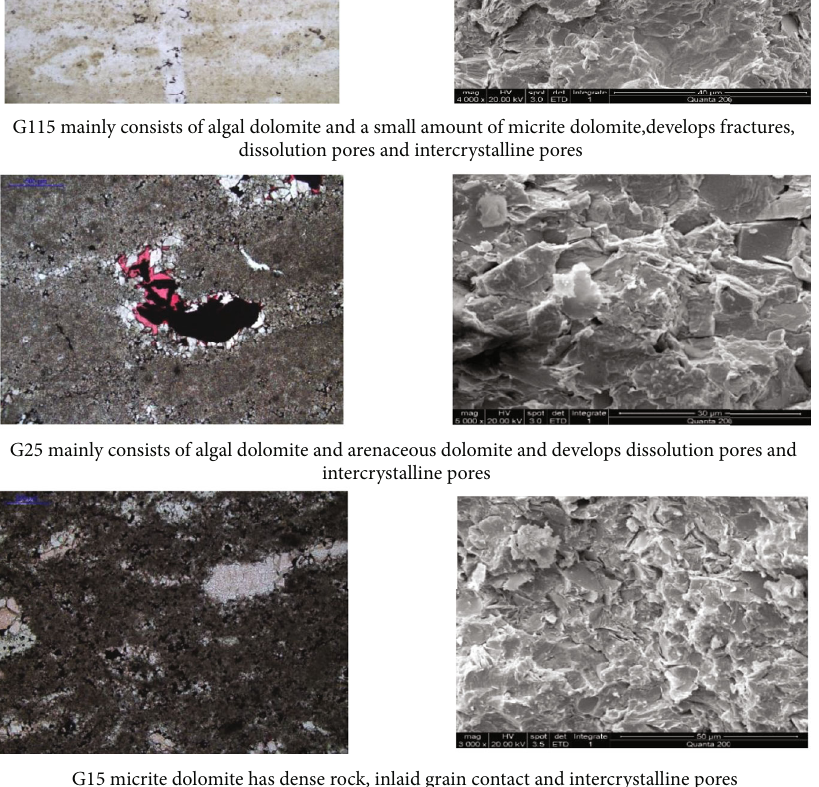
Figure 1: Reservoir spatial characteristics of di ff erent types of